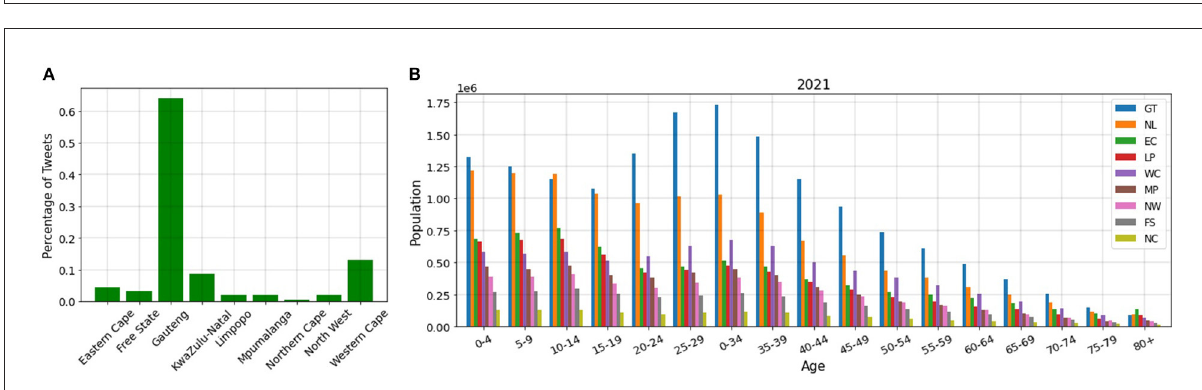
FIGURE11 (A) Number of tweets in each province, (B) Distribution of age population on different provinces.